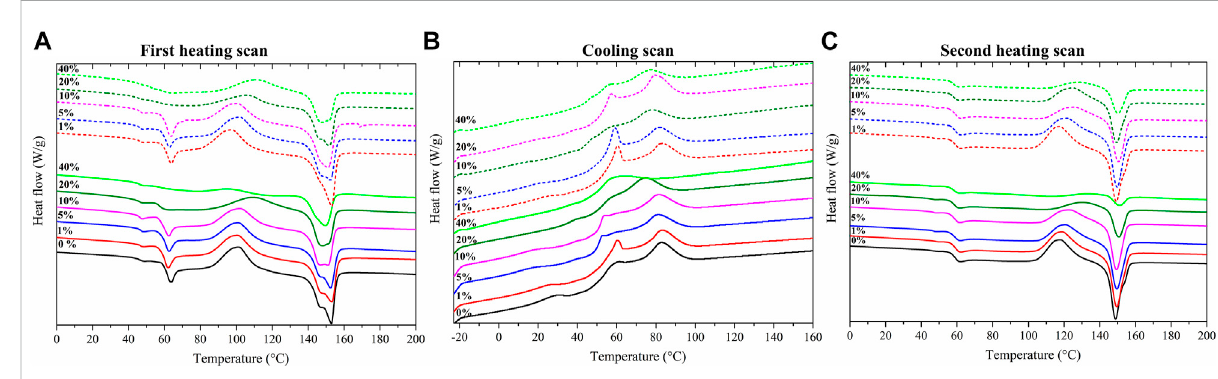
FIGURE 4 DSC curves of (A) fi rst heating scan, (B) cooling scan and (C) second heating scan. (A – C) : Continuous lines — PLA + X % of KL and Dashed lines — PLA + X % of OPKL. ( X is 1, 5, 10, 20, and